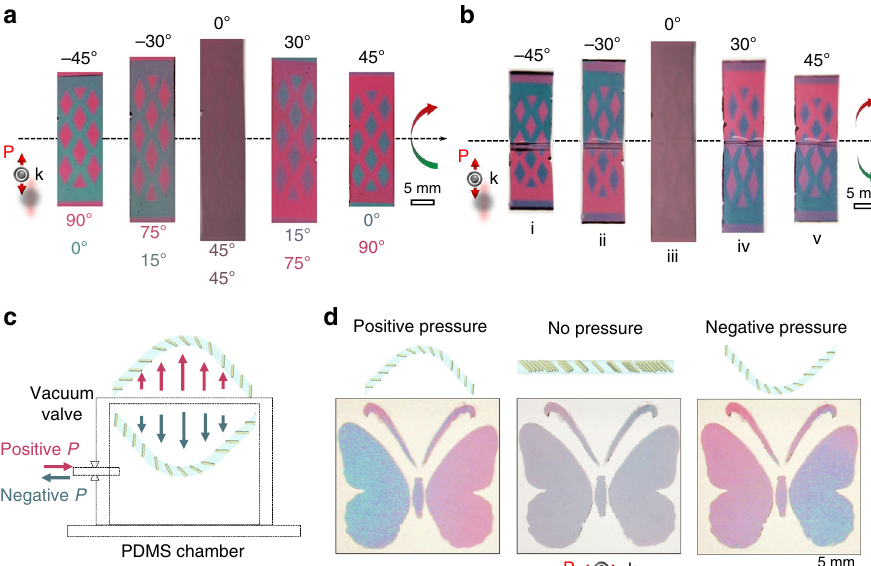
Fig. 5 Mechanochromic devices. Top views of the plasmonic fi lms under ( a ) rotation and ( b ) bending. The numbers below the images in ( a ) indicate the longitudinal mode angles ( ɸ L ) of cAuNRs embedded in the regions as indicated by the same color of the angles. In ( a ), the plasmonic fi lm was rotated left- handed. In ( b ), negative bending angles (i and ii) indicate bending backward while positive angles (iv and v) indicate bending forward. c Scheme showing the mechanochromic pressure sensor. d The cAuNRs are aligned 45 o to the surface normal in the butter fl y patterns (middle panel). When subjected to pressure, the top plasmonic fi lm expands upward or downward and exhibits asymmetric mechanochromic response in the two wings of the butter fl y due to the excitation of different plasmon modes of